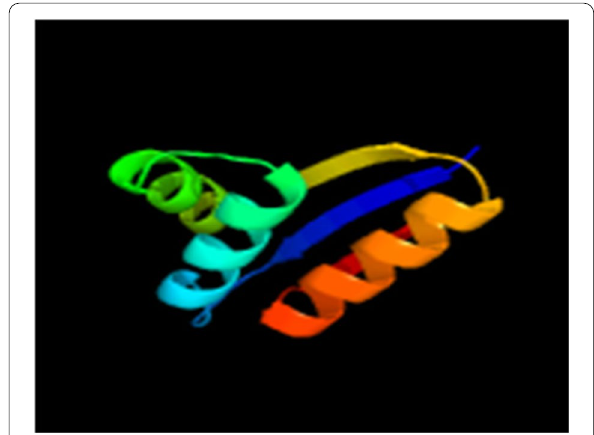
Fig. 3 Predicted tertiary structure of vaccine in